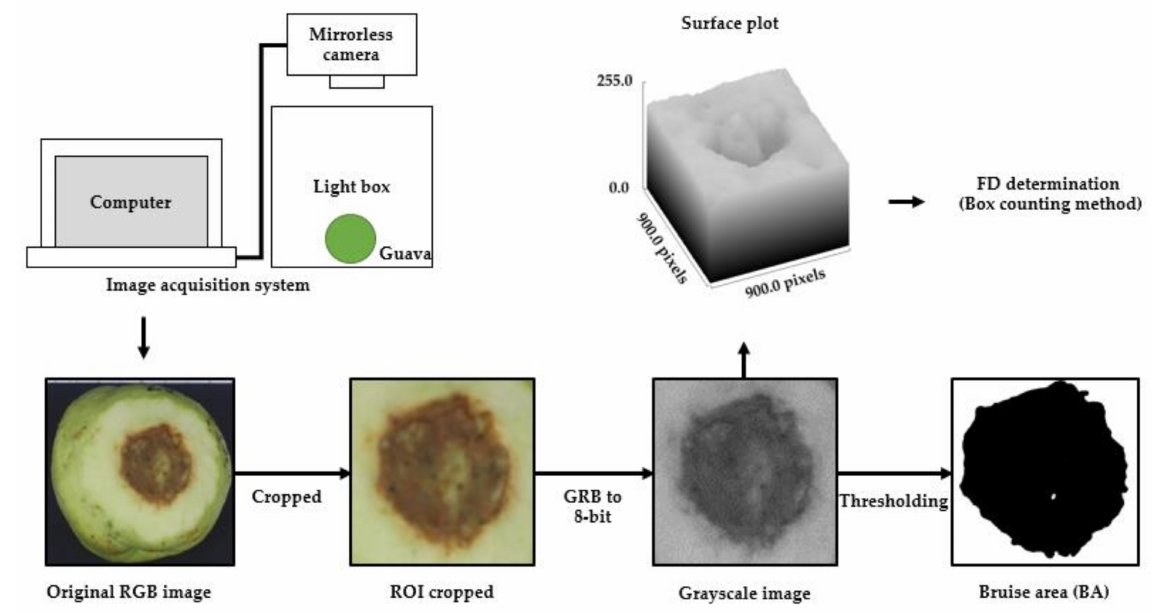
Figure 3. Image acquisition system and image analysis procedure for impact bruise